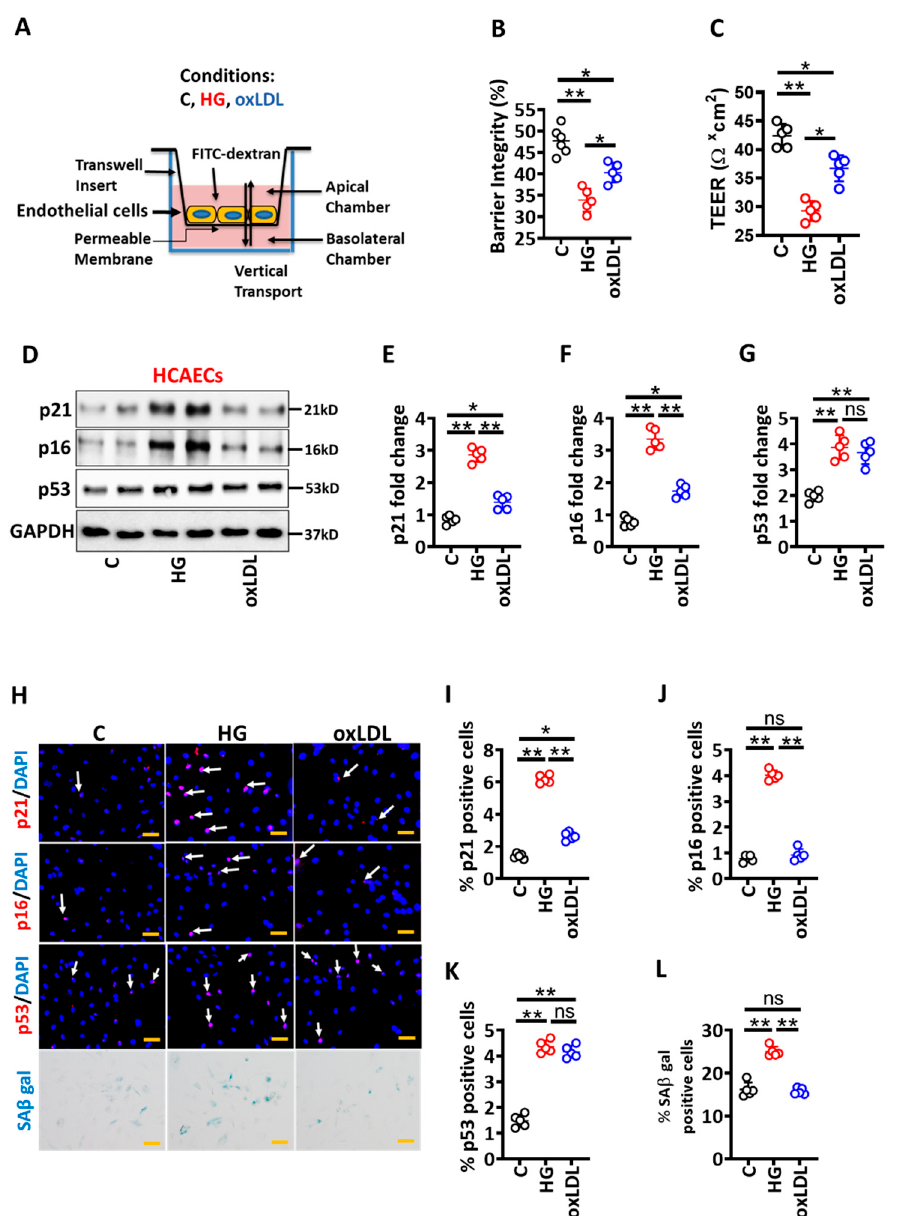
Figure 1. Hyperglycaemia-induced senescence promotes barrier disruption in endothelial cells. ( A ) Experimental design and treatment conditions. ( B , C ) Dot plot summarizing data of barrier integrity measured by FITC dextran leakage ( B ) and TEER ( C ). ( D – G ) Exemplary immunoblot of p21, p16, and p53 (( D ), loading control: GAPDH) and dot plot summarizing p21 ( E ), p16 ( F ) and p53 ( G ) densitometric quantifications of immunoblots. ( H – L ) Representative immunofluorescence images showing endothelial cell staining for p21 (( H ), top panel, red; nuclear counterstain: DAPI, blue), p16 (( H ), first middle panel, red; nuclear counterstain: DAPI, blue), p53 (( H ), second middle panel, red; nuclear counterstain: DAPI, blue) and senescence-associated beta galactosidase staining (( H ), bottom panel, blue). Dot plots summarizing data for p21 ( I ), p16 ( J ), p53 ( K ) and SA β gal ( L ). Scale bar: 20 µ m ( H ). HCAEC maintained under control (non-treated, C), high glucose (25 mM; HG) or oxidized low density lipoprotein (oxLDL 50 µ g/mL, oxLDL) conditions. Each dot represents data obtained from one biological specimen; * p < 0.05, ** p < 0.01; ANOVA. To find the in vivo relevance of these findings, we determined p21, p16, and p53 levels in the brachiocephalic artery of ApoE − / − mice with persistent